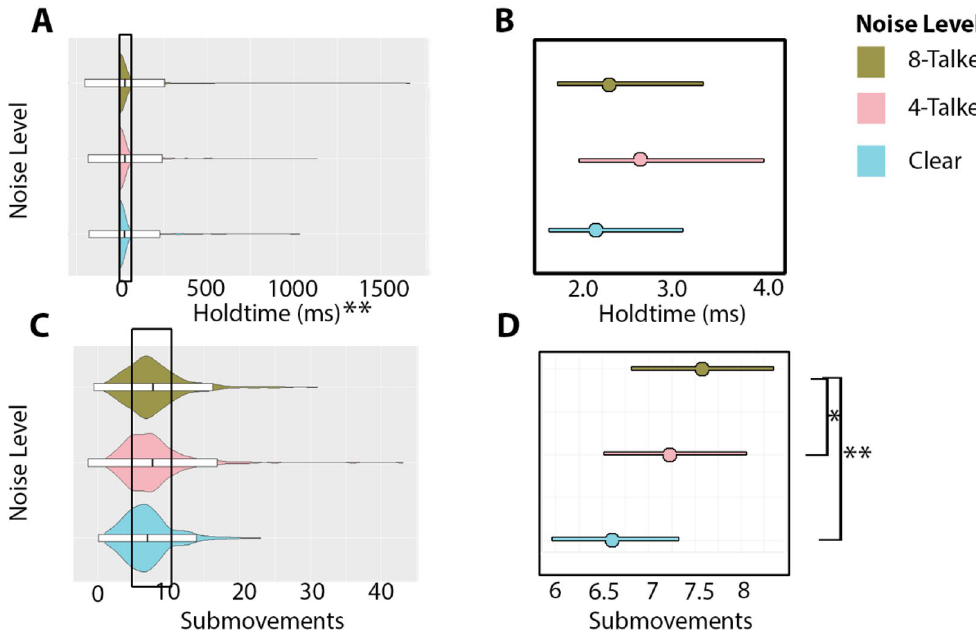
Figure 2. Overview of significantly affected body kinematics across noise levels. Panel ( A ) depicts the raw distribution of holdtime values, while panel ( B ) depicts the model estimates for holdtime. Panel ( C ) provides the raw distribution of submovement values, while panel ( D ) depicts the model estimates for submovements. In panels ( A ) and ( B ), the y-axis shows the three noise levels in ascending order, while the x-axis shows the raw kinematic values. Violins represent the kernel probability of the data at each point. Within each violin a boxplot shows the mean (middle bar) and two standard deviations from the mean (box hinges). In panels ( C ) and ( D ), the predicted kinematic values are based on noise level, while holding all other random terms constant. The central circle provides the mean, while the bars on either side provide the confidence intervals based on standard error. Significant contrast comparisons between noise levels are indicated by a bracket. The significant main effect of Holdtime is indicated by asterisks on this plot. * p < 0.05. ** p < 0.001.